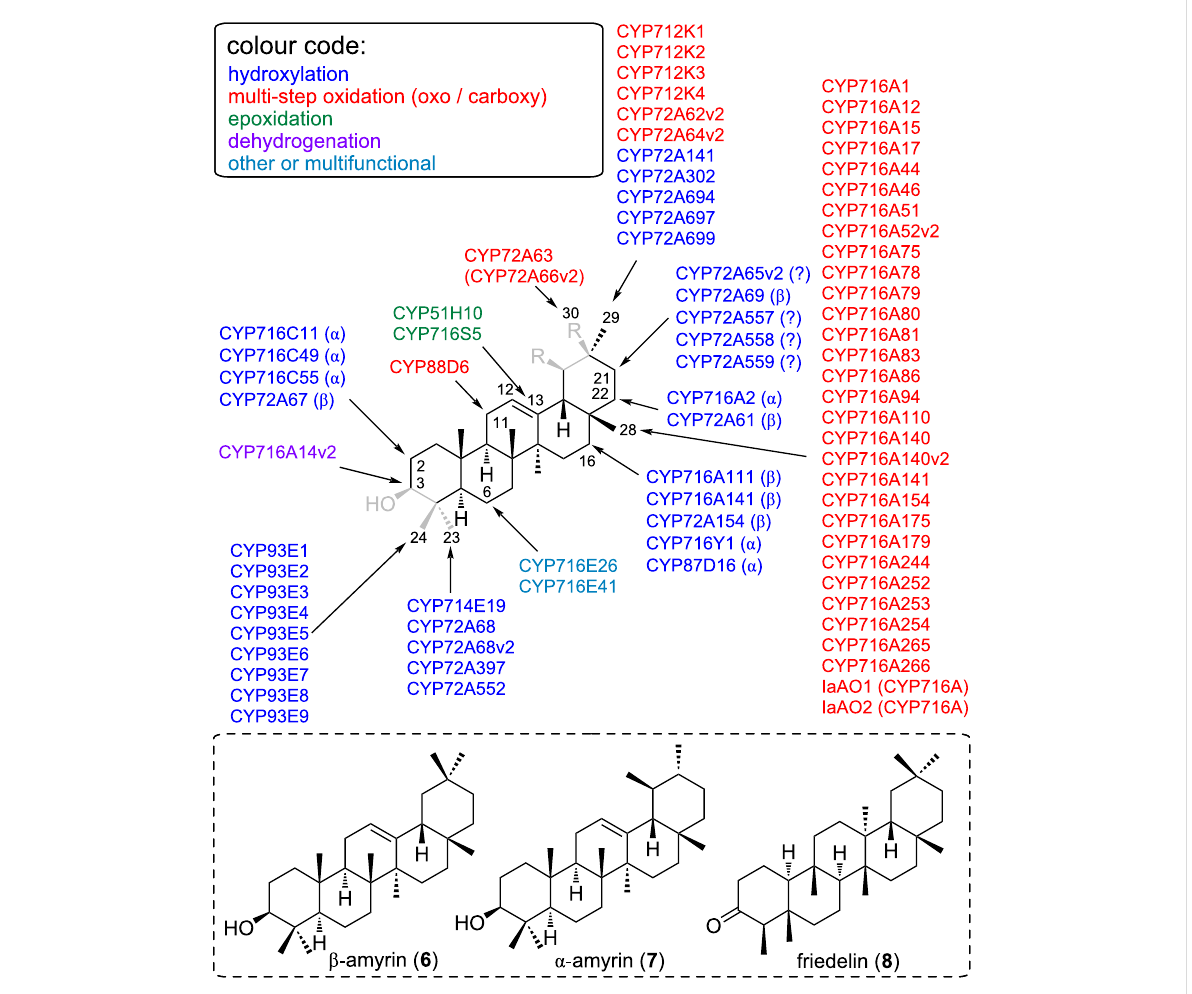
Figure 4: CYPs modifying pentacyclic 6-6-6-6-6 triterpenes. Substructures in grey indicate regions where major structural differences occur between different substrates of the same class. Representative substrate skeletons (not exact substrates) are shown in the dotted boxes. For exact substrate specificity see Table